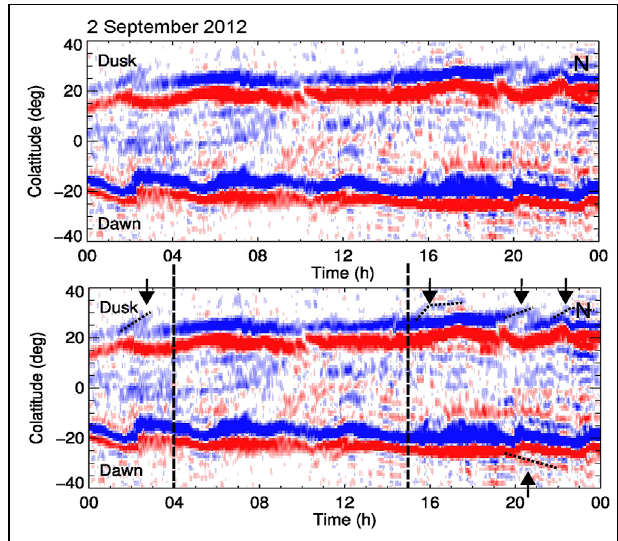
FIGURE 2 | An example of an AMPERE FAC keogram used to identify R2Bs. The data were taken from 2 September 2012, in particular the dawn-dusk axis. Upward FACs are shown in red and downward FACs in blue, in the same scale as Figure 1 . Both plots are showing the same data, with the second showing the annotated version allowing for the R2Bs to be clearly identified. The arrows indicate the dawn and dusk R2B occurrences at 20 UT and 02, 16, 20, and 22 UT, respectively. The dotted lines follow the evolution of the events throughout the day. The time between the dashed lines (04 and 15 UT) shows the period with no R2B activity